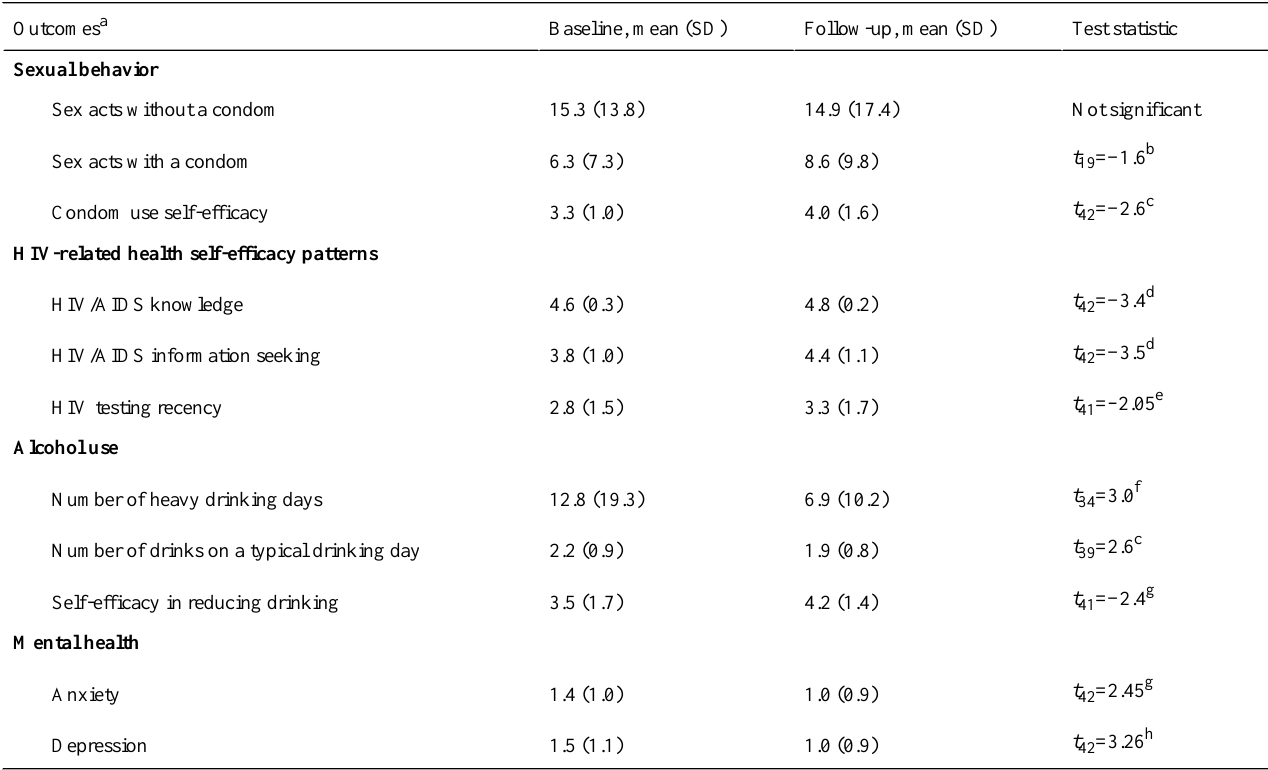
Table 2. Reported HIV-related behavior, alcohol use, HIV/AIDS knowledge, and mental health outcomes pre-post